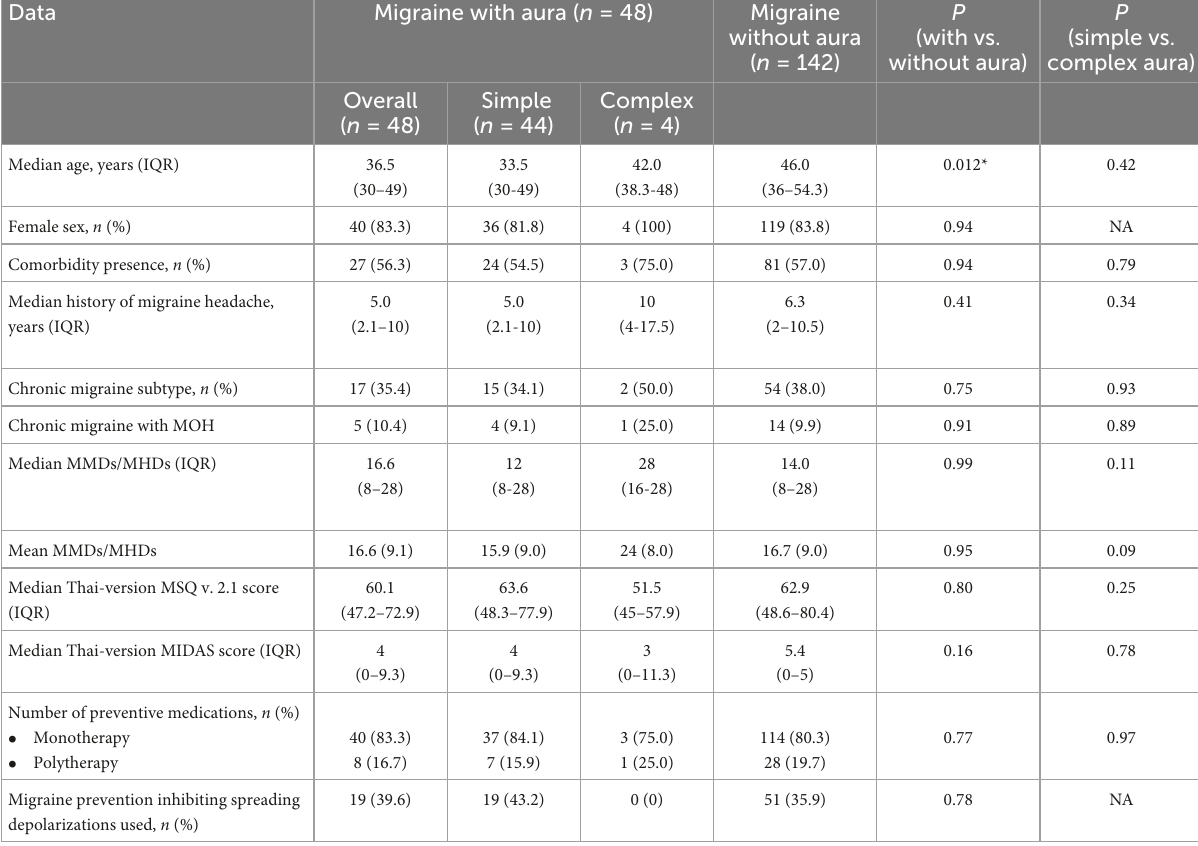
TABLE 1 Baseline age, sex, and migraine data for migraine patients with simple or complex aura and without aura taking migraine preventive medication. Data Migraine with aura ( n = 48) Migraine